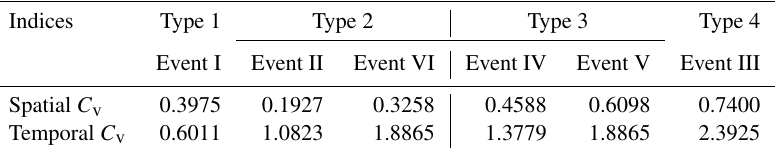
Table 3. Spatial and temporal C v of the observed rainfall for the six storm